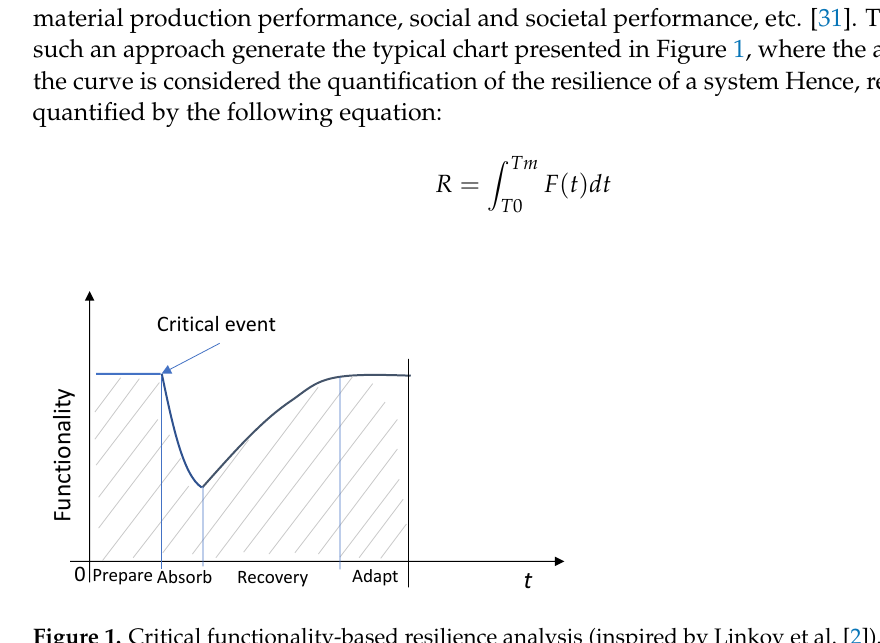
Figure 1. Critical functionality-based resilience analysis (inspired by Linkov et al.